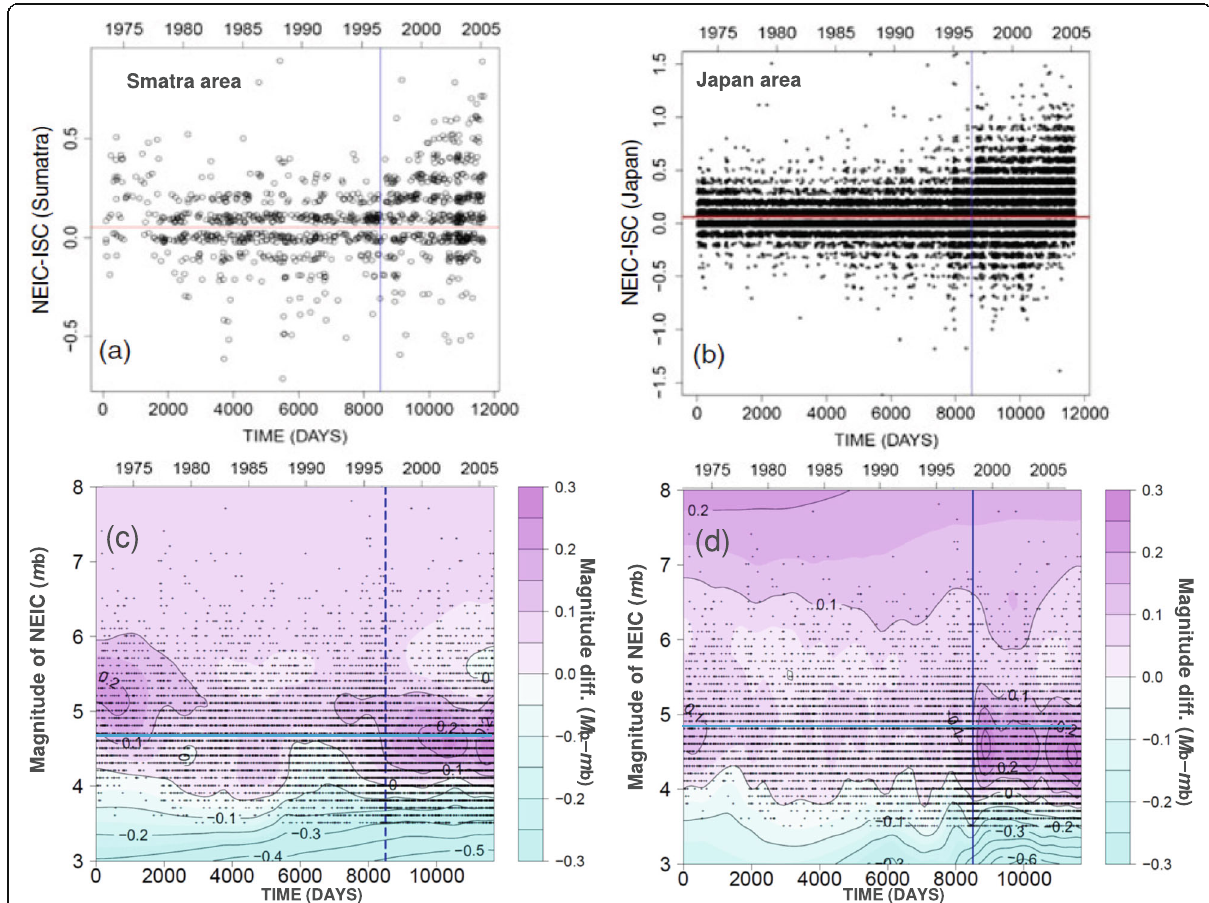
Fig. 3 Magnitude differences in USGS body wave magnitude m b and ISC body wave magnitude M b (1973 – 2005). M b – m b is shown in the a Sumatra area and b Japan area. Because the magnitude differences are 0.1 interval unit, the magnitude differences are plotted with small perturbations. The horizontal red lines are mean differences during the earlier period until 8500days. The smoothed surfaces of M b – m b on the plane of m b over the period are shown in c Sumatra area and d Japan area. Contours show an equidistance of 0.1 magnitude unit differences of the smoothed surface, and thin and thick purple show higher magnitudes differences than thin and thick light blue. The horizontal light blue line represents the lowest magnitude of completeness, M c = 4.7. The vertical dark blue lines show changes of the magnitude difference pattern in the range where plots were highly